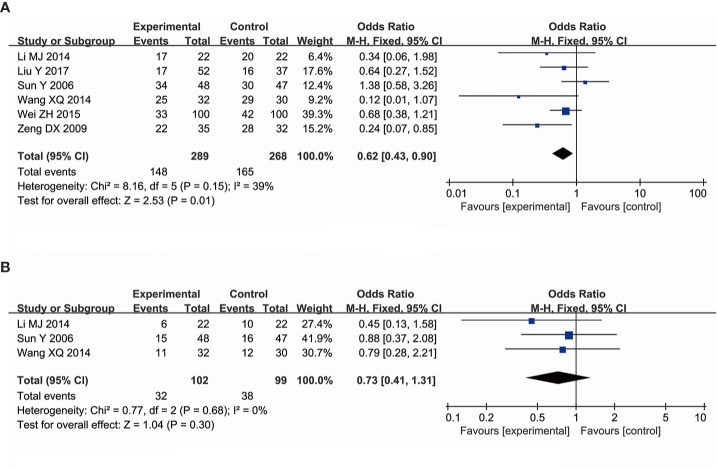
Forest plot for the decline of neutrophil counts. (A) The decline of neutrophil counts I–IV. (B) The decline of neutrophil counts III–IV.